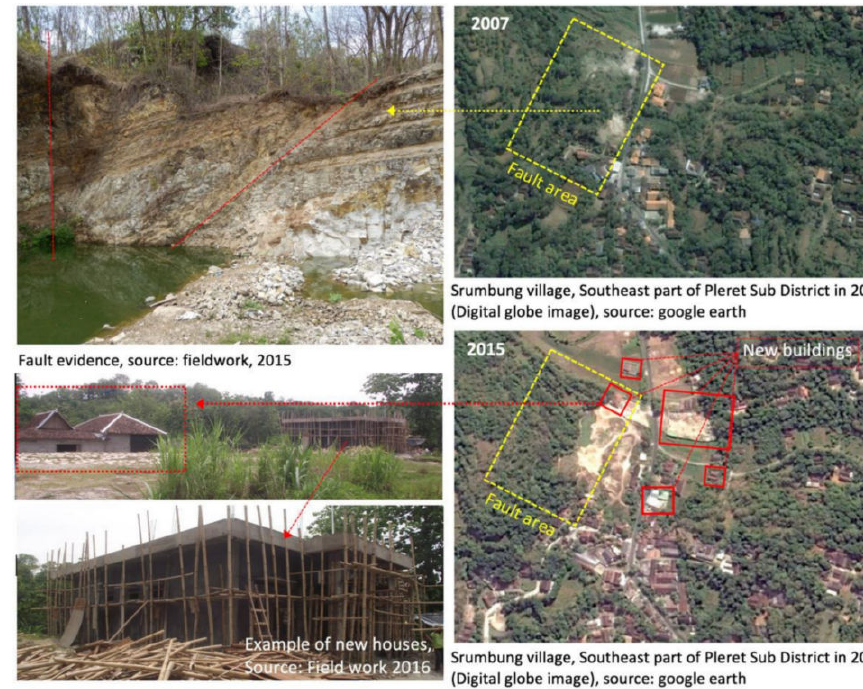
Figure 5. New building which was built close to fault zone in Srumbung